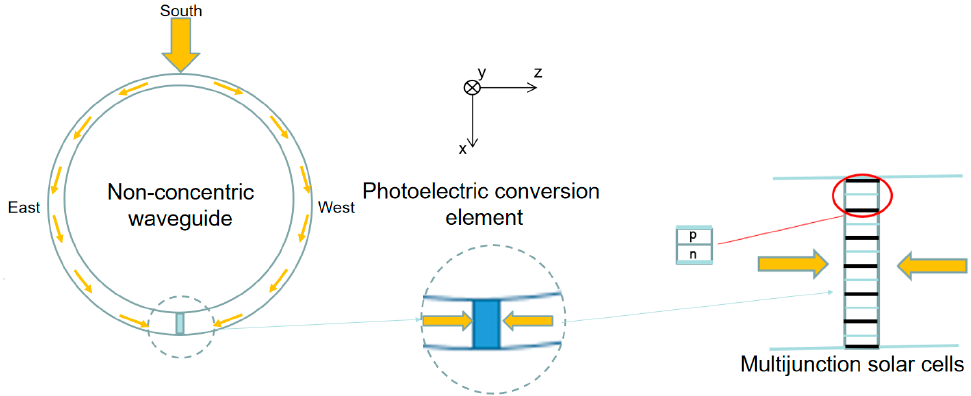
Figure 9. ( Left ) Cylindrical 2DPRCS photovoltaic system with nonconcentric cross-section waveguide and multijunction solar cells (shown in Figure 8a). ( Middle ) Enlarged view of the photo-electric conversion element. ( Right ) Cross-section of the photoelectric conversion element. The yellow arrow shows the propagation of sunlight. For the photoelectric conversion element composed of multijunction solar cells, sunlight coming through counterclockwise and clockwise routes, as well as sunlight from the east, south, and west sides, can be utilized.